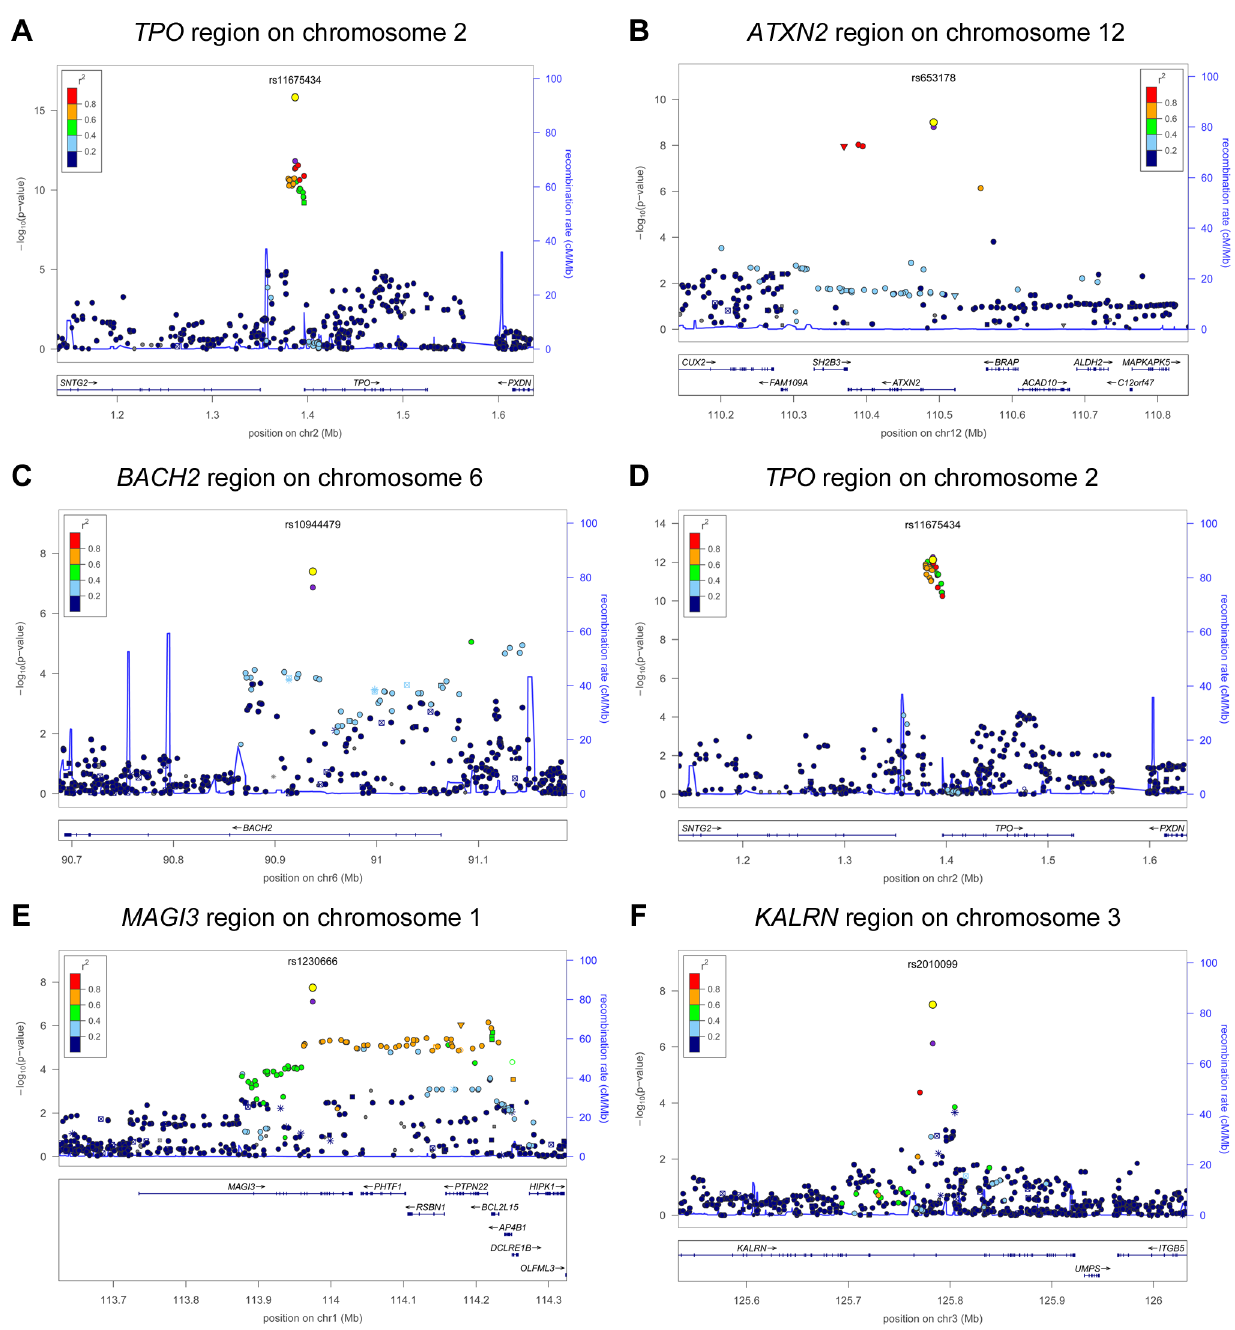
Figure 1. Genome wide association studies meta-analyses: Loci associated with TPOAb-positivity (a–c) and TPOAb levels (d–f) on a genome-wide level of significance. Regional association plots of the genome-wide significant loci associated with TPOAb positivity (a–c) and TPOAb levels (d–f). The y-axis on the left indicates the – log 10 P value for the association with TPOAb –positivity (a–c) or TPOAb levels (d–f). SNPs are plotted on the x-axis according to their chromosomal position against the association with the phenotype on the y-axis. The most significant stage 1 SNP is indicated in purple. The combined stage 1 and 2 result of this SNP is indicated in yellow. The SNPs surrounding the most significant SNP are color-coded to reflect their LD with this SNP. Symbols reflect functional genomic annotation, as indicated in the legend. The blue y-axes on the right of each plot indicate the estimated recombination rates (based on HapMap Phase II); the bottom of each panel shows the respective annotated genes at the locus and their transcriptional direction. Mb,